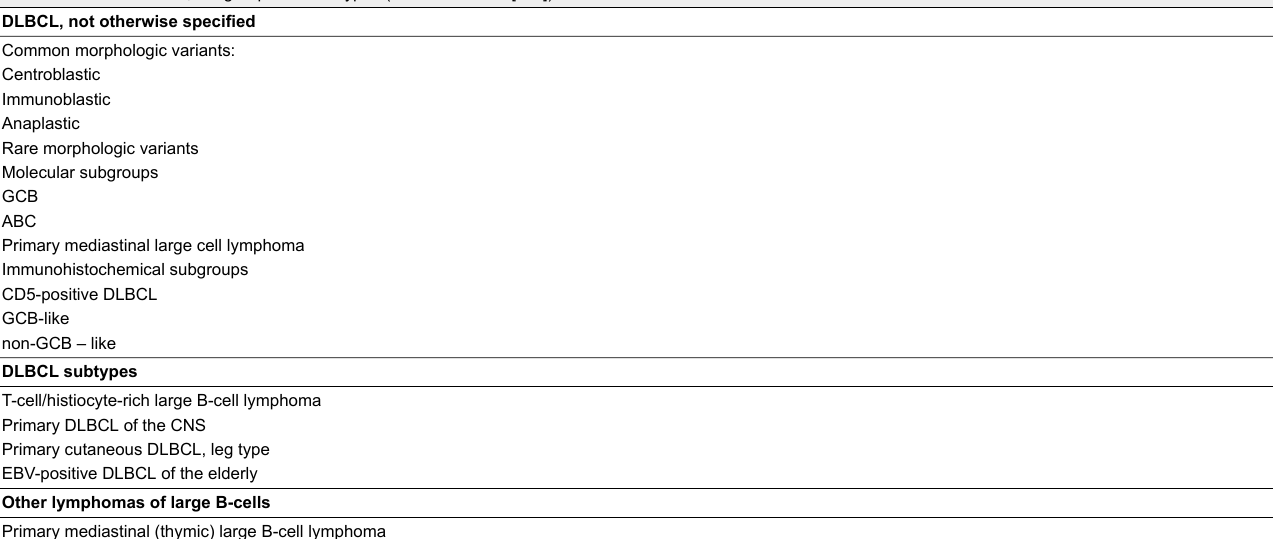
Table 1: DLBCL variants, subgroups and subtypes (from Jaffe et al. [116]). DLBCL, not otherwise specified Common morphologic variants: Centroblastic Immunoblastic Anaplastic